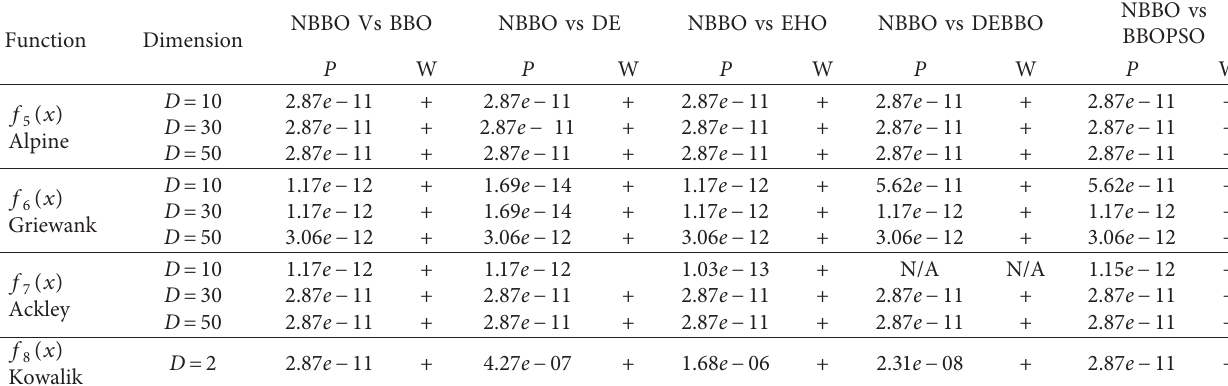
Table 6: Wilcoxon rank sum test results of multimodal